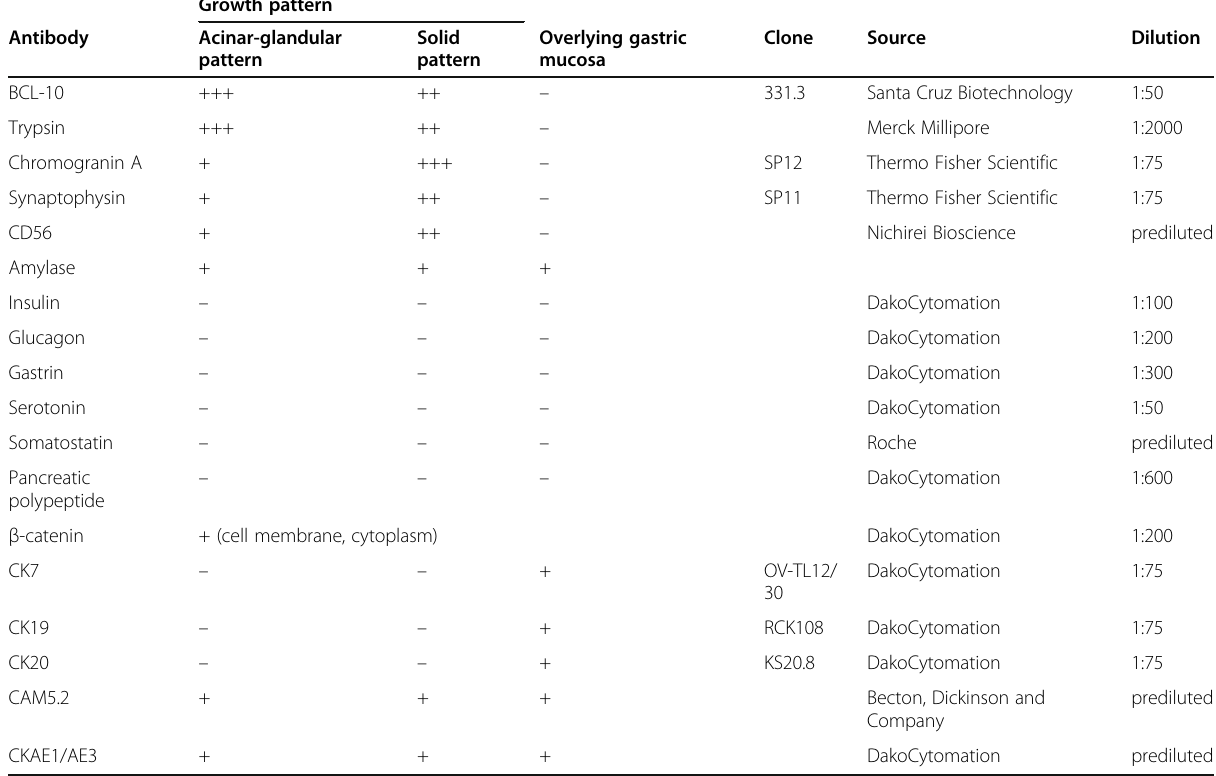
Table 1 Antibodies employed in the immunohistochemical study and results Growth